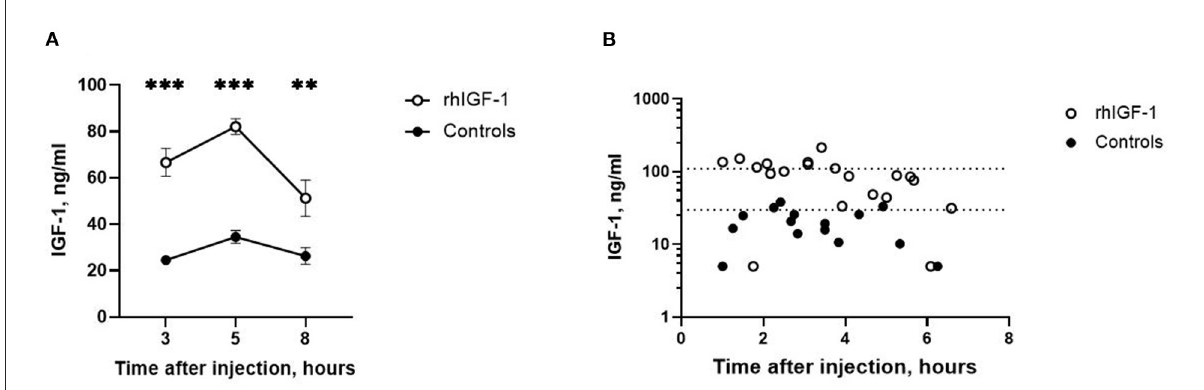
FIGURE2 Circulating IGF-1 levels in Experiment 1. (A) Plasma IGF-1 levels in rhIGF-1 and control preterm pigs after a subcutaneous injection of rhIGF-1 or vehicle (mean ± SEM, n = 13–26). (B) Plasma IGF-1 levels at euthanasia 1–7h after the last subcutaneous injection of rhIGF-1 or vehicle on day 9. Each point represent one pig. The dotted lines indicate the desired physiological range. IGF-1, insulin-like growth factor-1; rhIGF-1, recombinant human insulin-like growth factor-1. ** p < 0.01, *** p < 0.001.